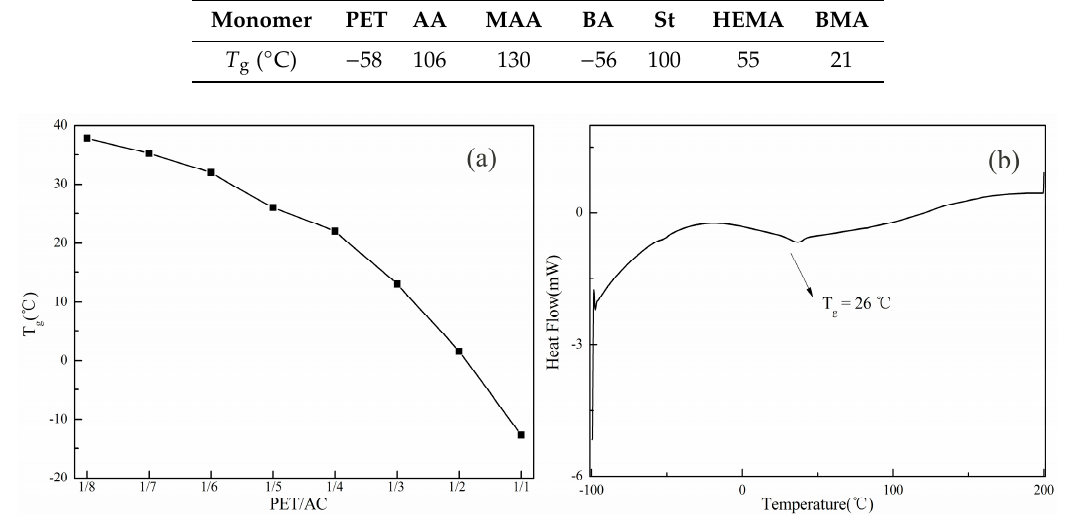
Figure 3. ( a ) E ff ect of the PET / AC ratio on the glass transition temperature of the film. ( b ) DSC Figure 3. ( a ) Effect of the PET/AC ratio on the glass transition temperature of the film. ( b )DSC thermogram of PET / AC was 1 / thermogram of PET/AC was 1/5.